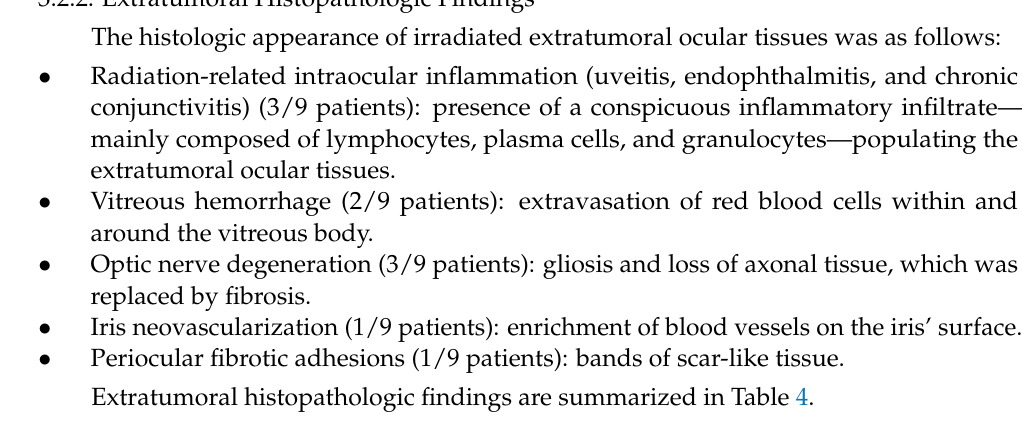
Table 4. Histopathologic findings with respect to irradiated extratumoral ocular tissues. Patient